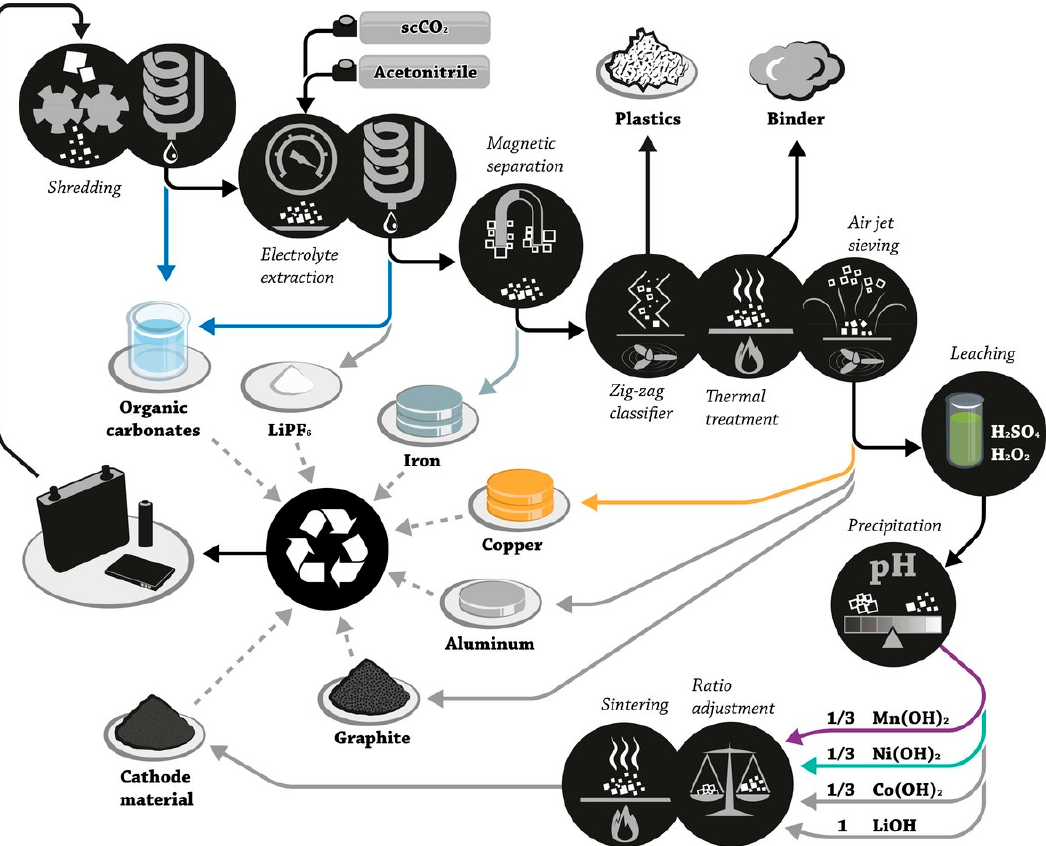
Figure 25. Schematic flowsheet for the LithoRec battery recycling process [304].